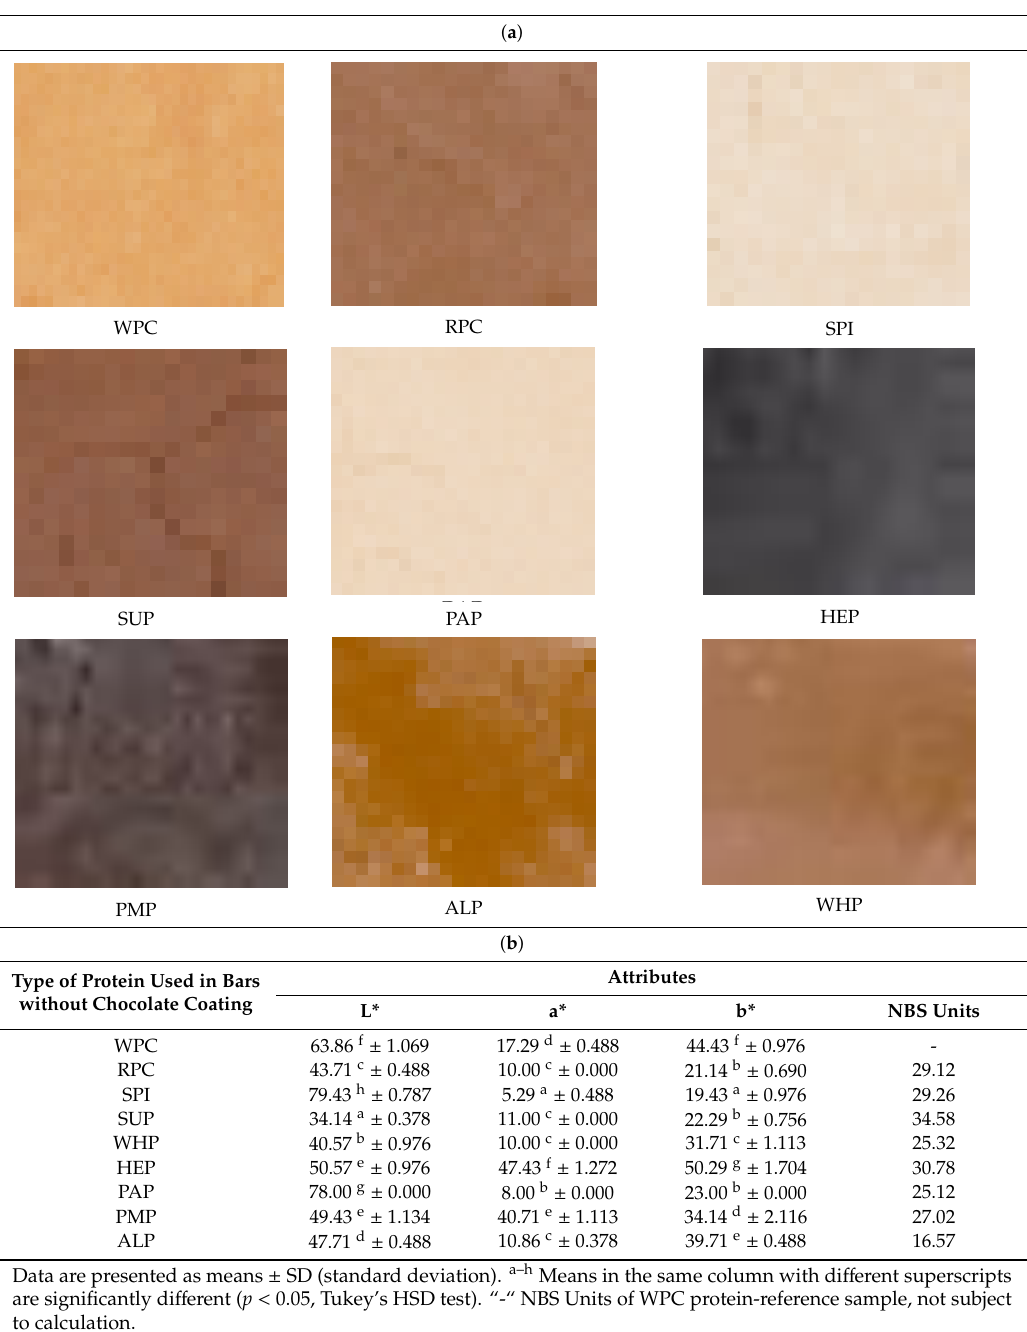
Table 4. ( a , b ) Effect of different protein application on color of high-protein bars without chocolate coating measured with Computer Vision System (CVS).